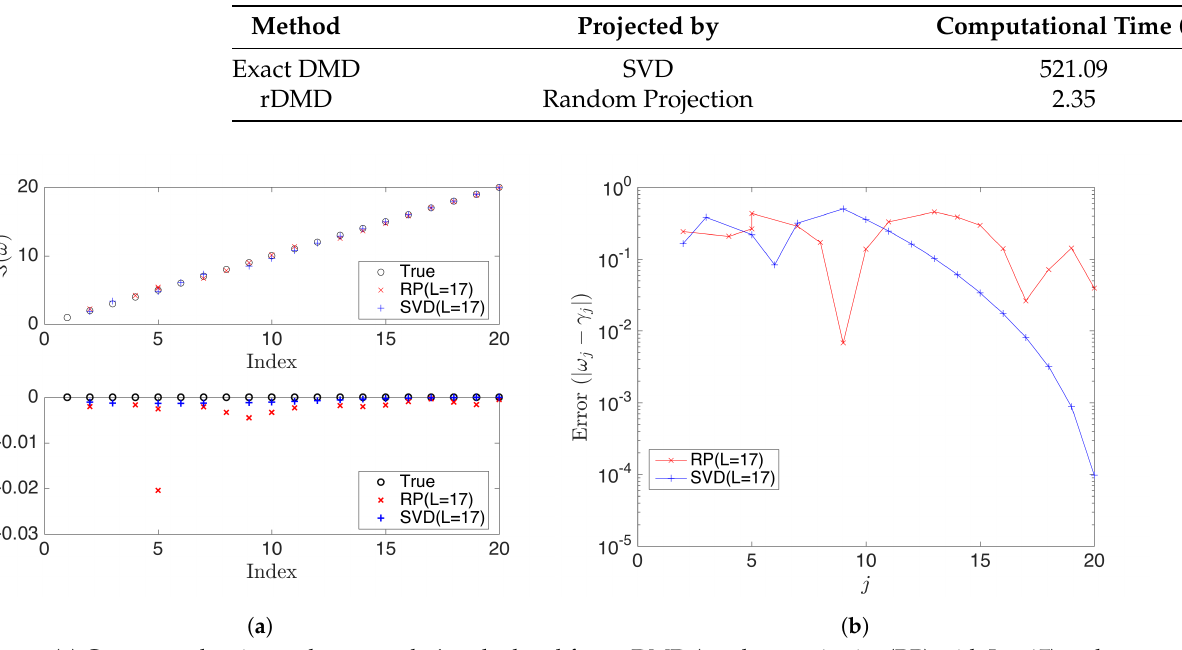
Table 2. Computational costs for the SVD-based exact DMD and random projection-based rDMD method for the data simulated by Equation (15). Computational costs of SVD for the high-dimensional snapshot matrix is relatively larger than random projection.